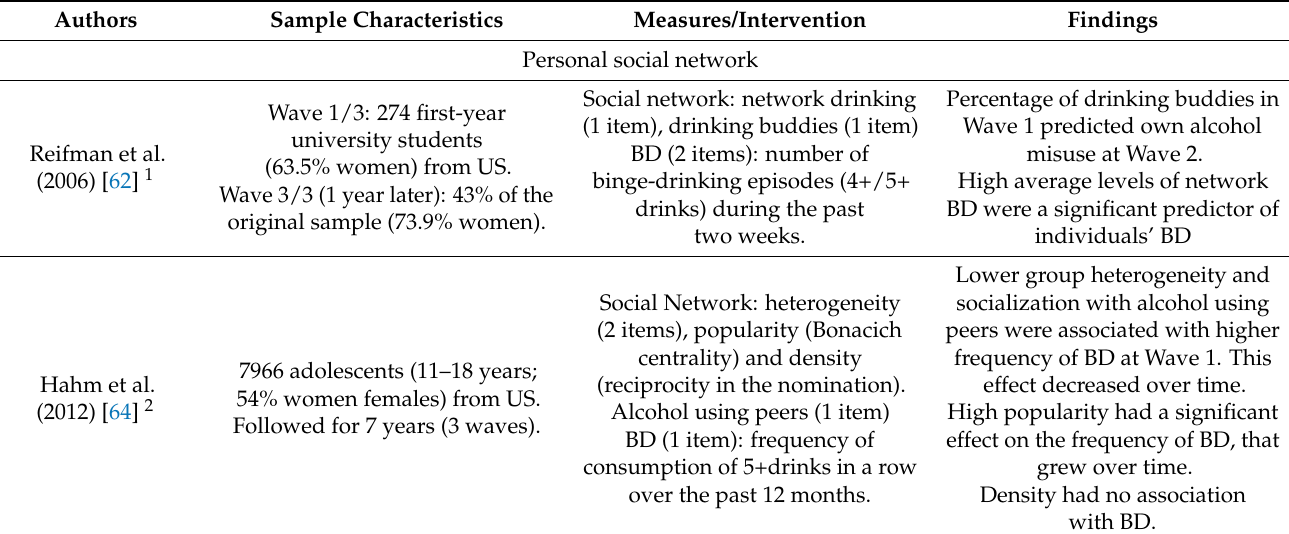
Table 2. Synthesis of Characteristics and Key Findings of Included